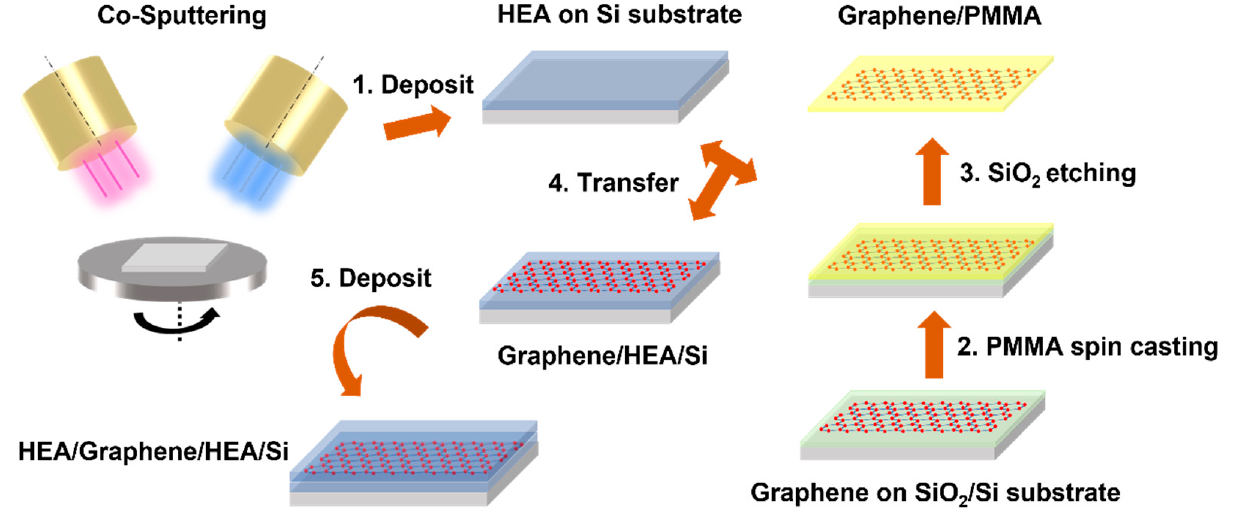
Figure 1. Schematic figure of the fabrication of NL HEA/graphene composites.